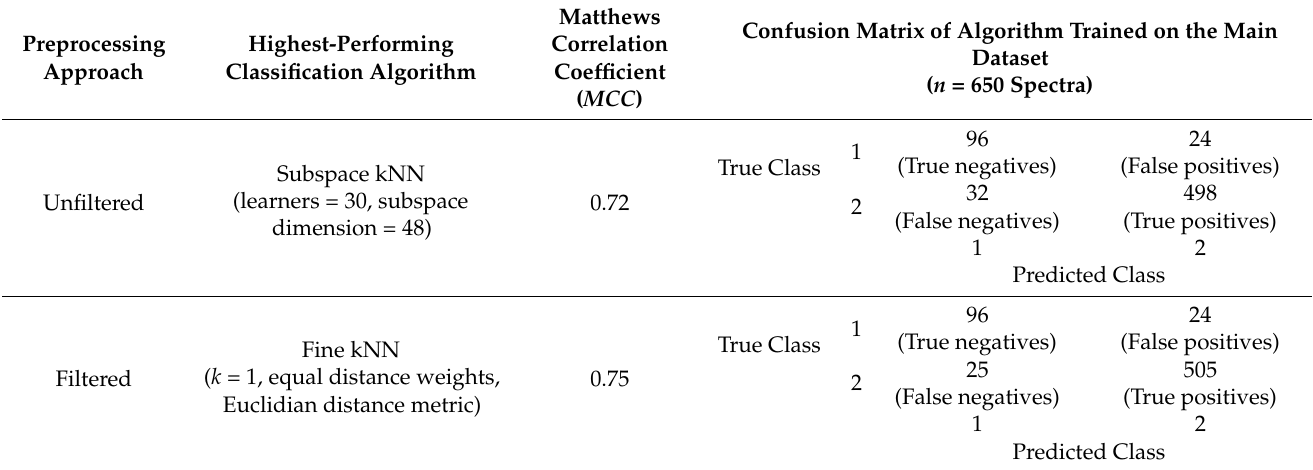
Table 2. Overview of the performance characteristics of the highest-performing classification algo- rithm trained on unfiltered and filtered spectra, respectively. A fine kNN algorithm trained on the filtered dataset of n = 65 teeth achieved the highest MCC , indicating its remarkable performance despite the imbalanced distribution of the